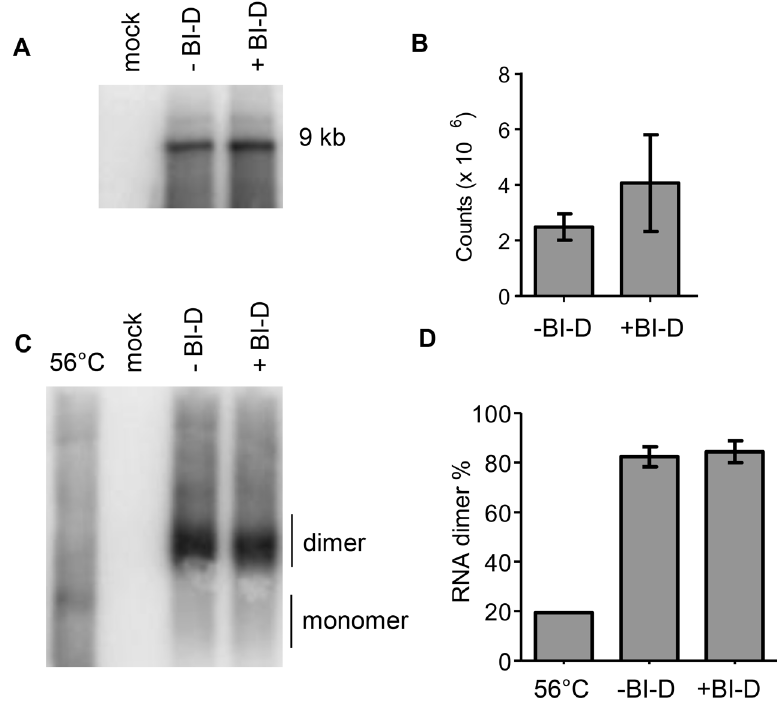
Figure 2. HIV-1 RNA packaging and dimerization. Viral RNA was isolated from virion particles produced in the presence or absence of BI-D. For mock samples, RNA was isolated from pBluescript-SK + transfected cells. A. Virus RNA was analyzed on a denaturing northern blot to measure RNA packaging. The position of the full-length 9 kb viral genome is indicated. B. Quantification of the 9-kb viral RNA detected in panel A. The average value (N=3) with SD is shown. C. Viral RNA was analyzed on a non-denaturing northern blot to analyze the dimerization status. The position of the dimer and monomer are indicated. To identify the position of the monomer, the – BI-D RNA sample was incubated at 56 u C for 10 min before analysis. D. The monomer and dimer bands observed in panel C were quantified to measure the level of dimerization. The average value with SD is shown (N=3).